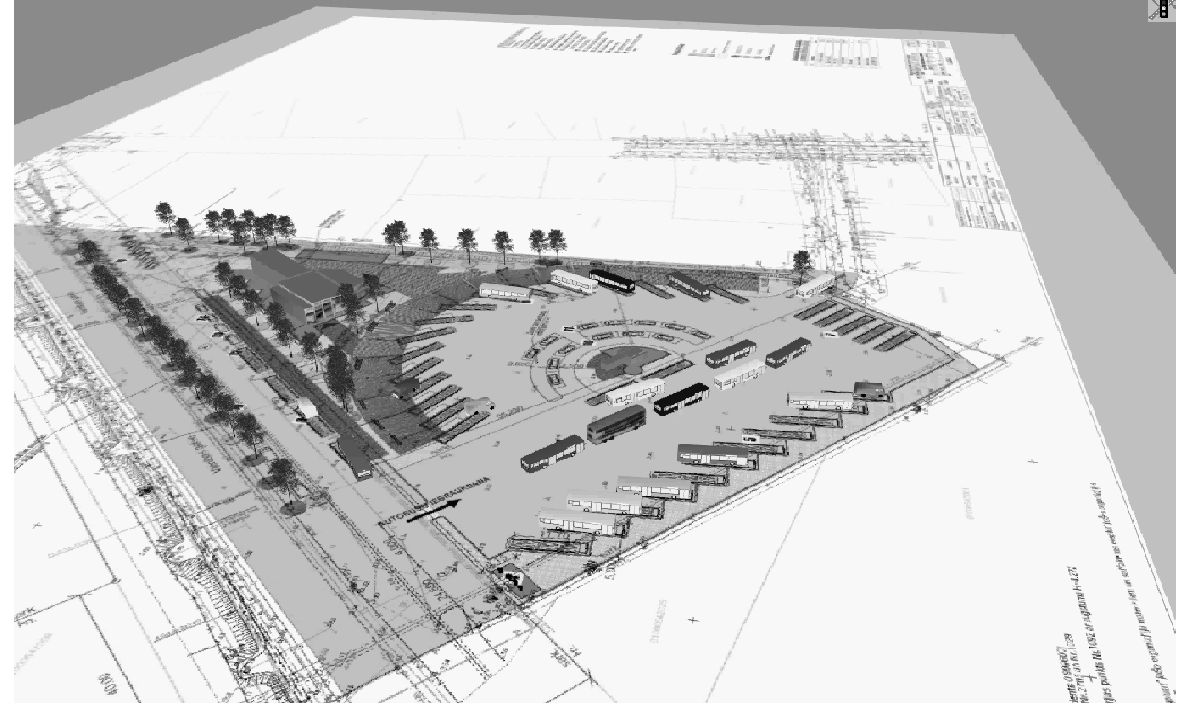
Fig 4. The simulation model of a new coach